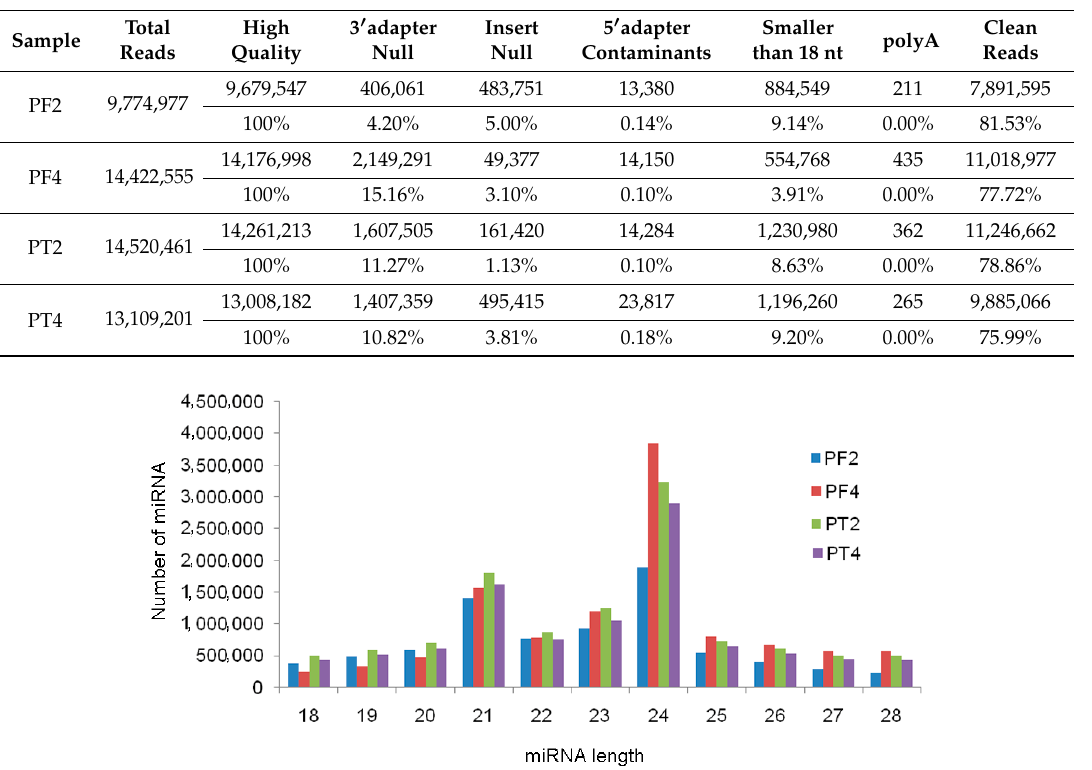
Table 2. Quality statistics of Paulownia’s sRNAs.